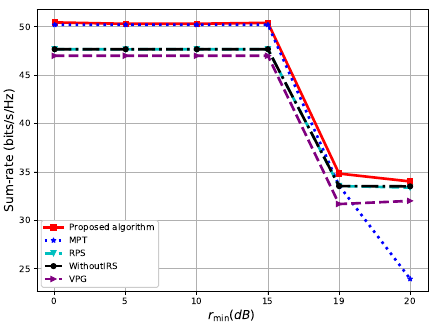
Figure 4. The network sum-rate versus the QoS threshold, r